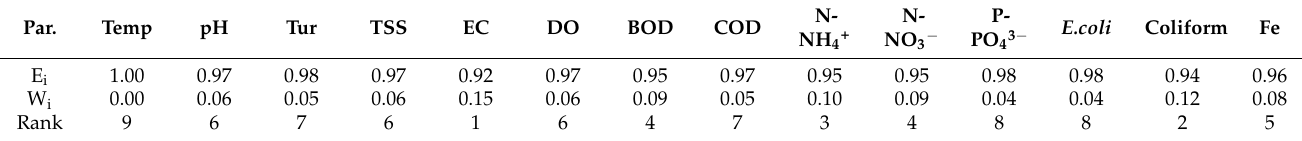
Table 3. Ranking of water pollutants based on the weight of